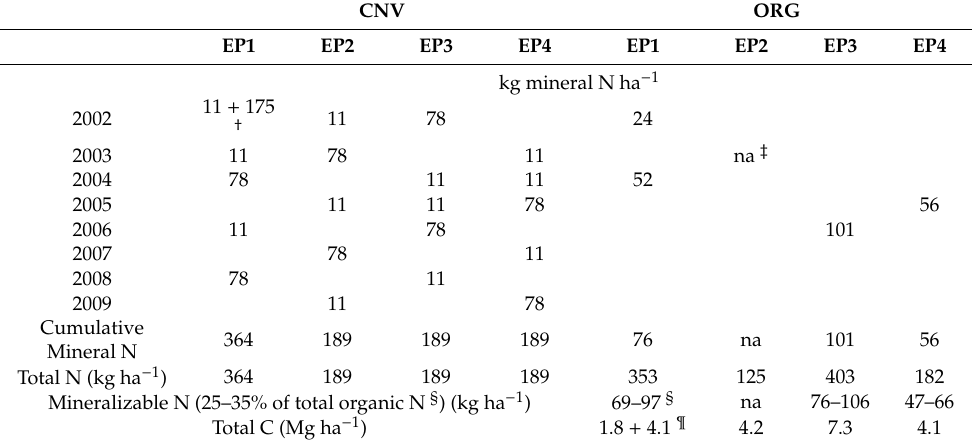
Table 2. Fertilizer N inputs by system, entry point and component (mineral N, total N) over the experiment,